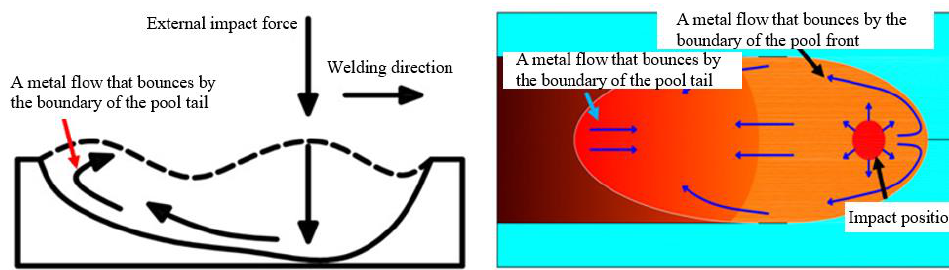
Figure 19. Schematic diagram of welding pool flow behavior.